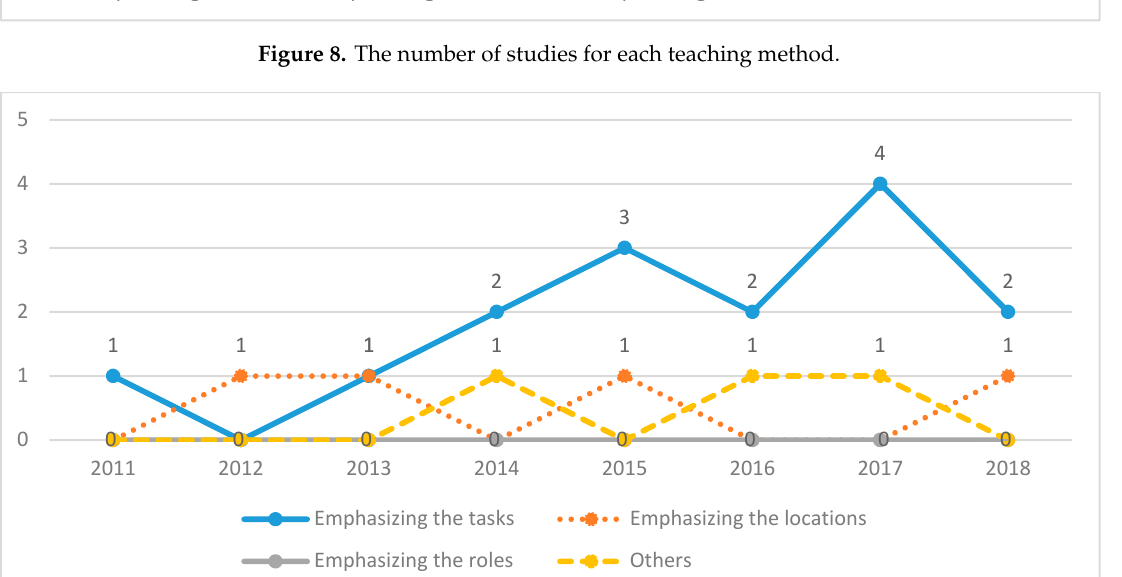
Figure 9. The number of AR teaching methods by year.